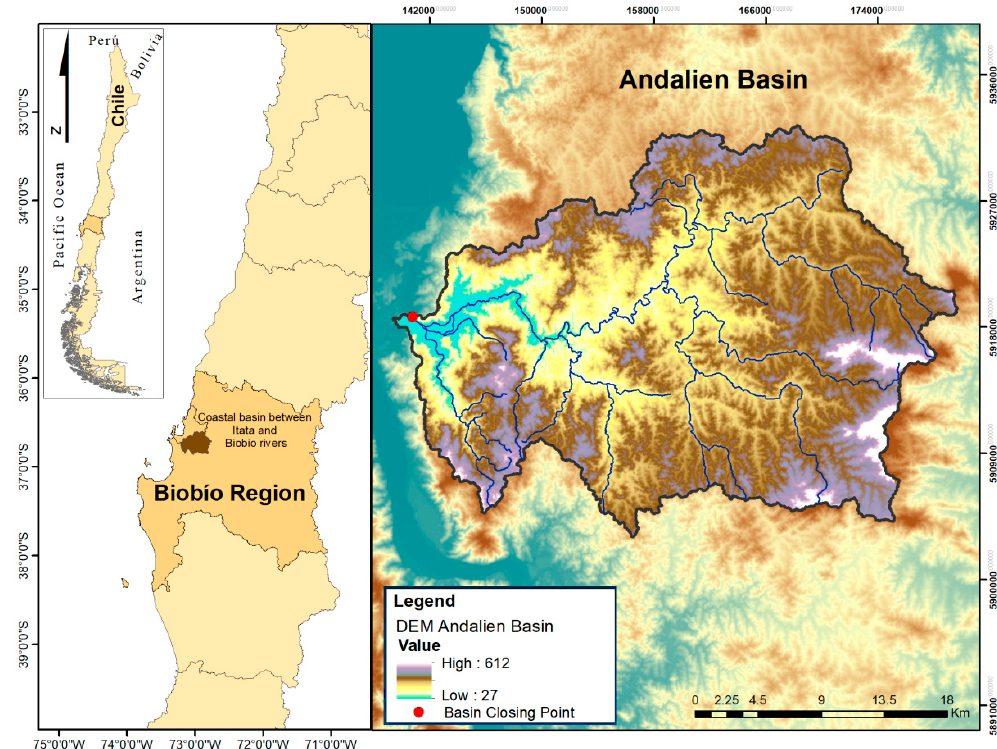
Figure 1. Andalien basin geographical location map.